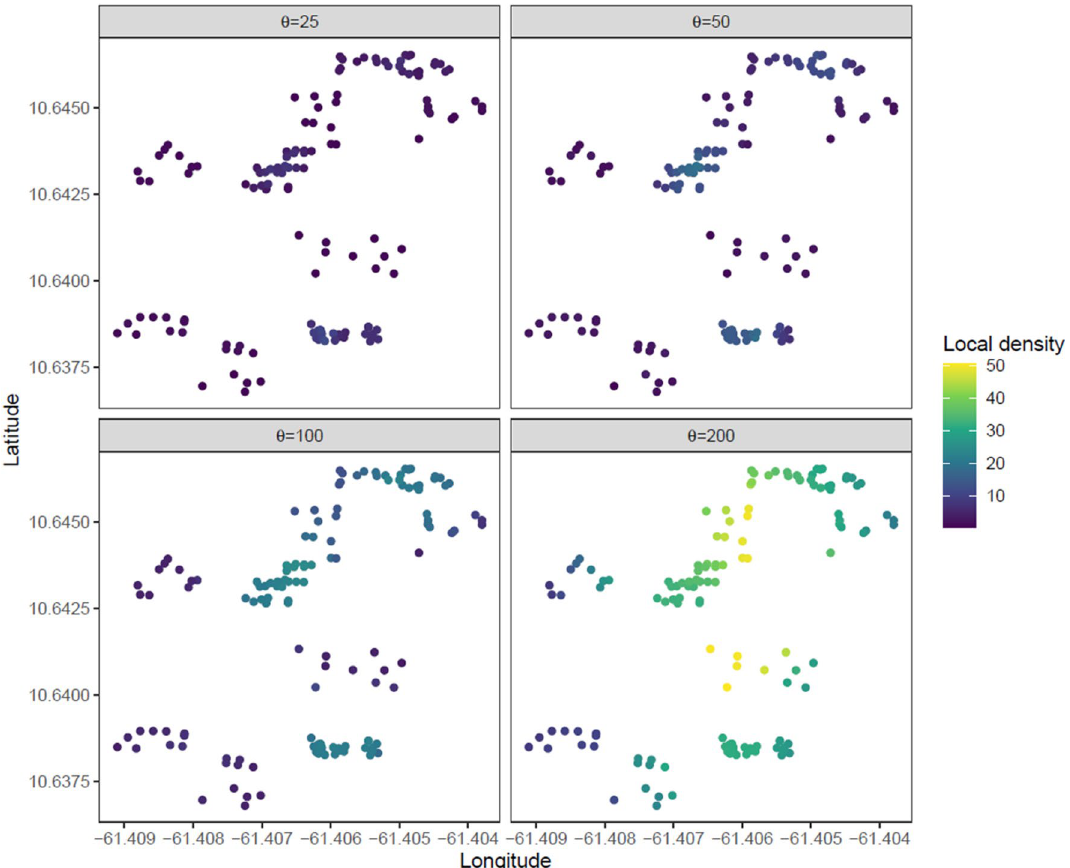
Figure 5. Relative positions of the ovitraps in space with illustration of local density measure. The relative physical locations of ovitraps are shown as dots with colors indicating the values of the local density measure under the four parameter levels used in the analysis. Heterogeneity in the spatial distribution of traps allows us to examine the effect of varying the local density of traps on the number of observed mosquito